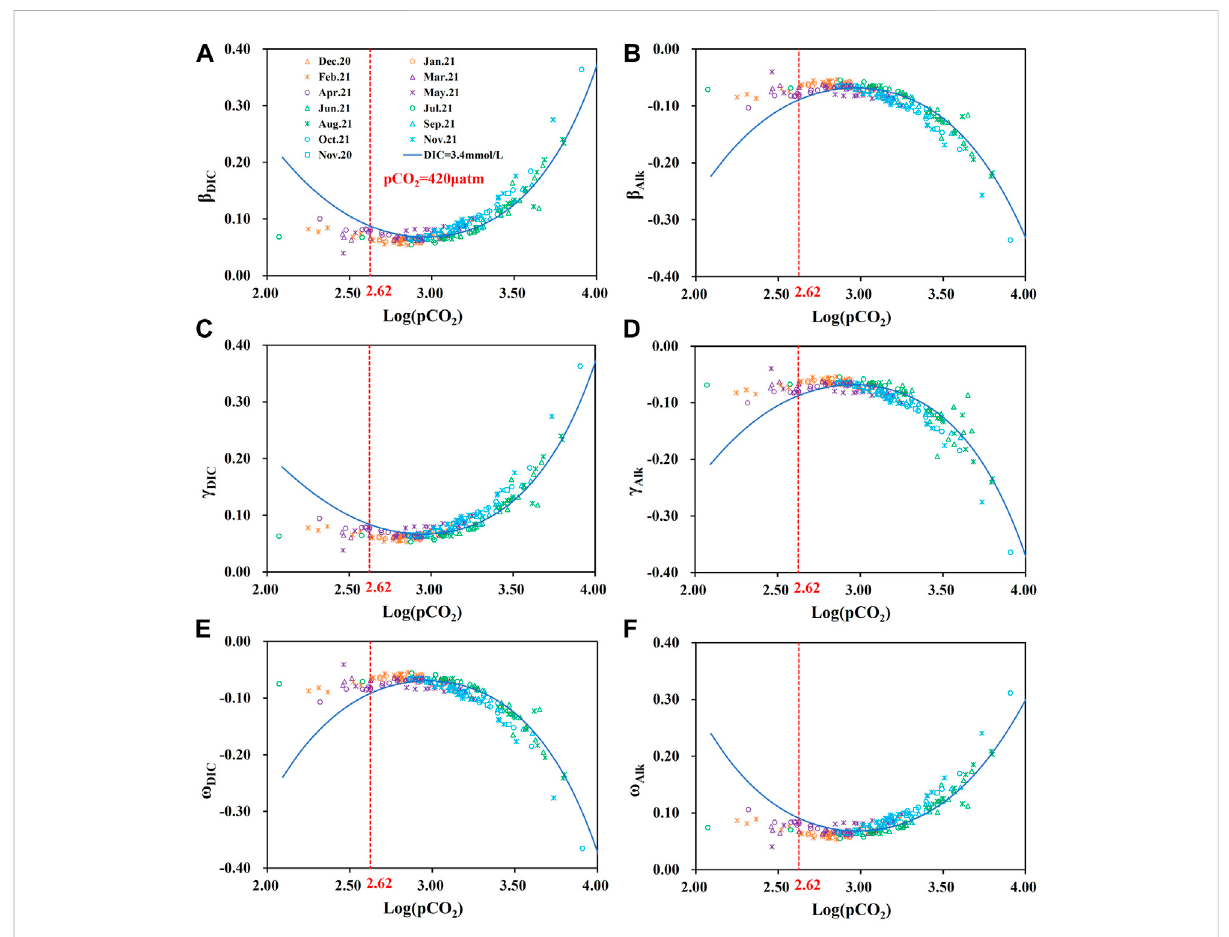
FIGURE 5 (A) Correlation between β DIC and Log(pCO 2 ); (B) Correlation between β Alk and Log(pCO 2 ); (C) Correlation between γ DIC and Log(pCO 2 ); (D) Correlation between γ Alk and Log(pCO 2 ); (E) Correlation between ω DIC and Log(pCO 2 ); (F) Correlation between ω Alk and Log(pCO 2 ) response in the Huatan River